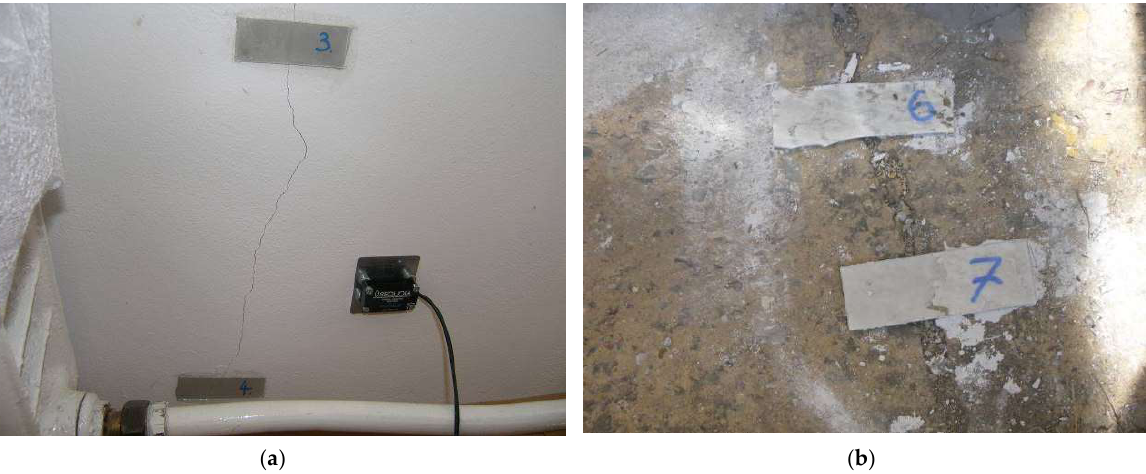
Figure 3. The view of control tapes: ( a ) No. 3 and 4 (inside the building—first floor) and ( b ) No. 6 and 7 on the concrete floor around the building.